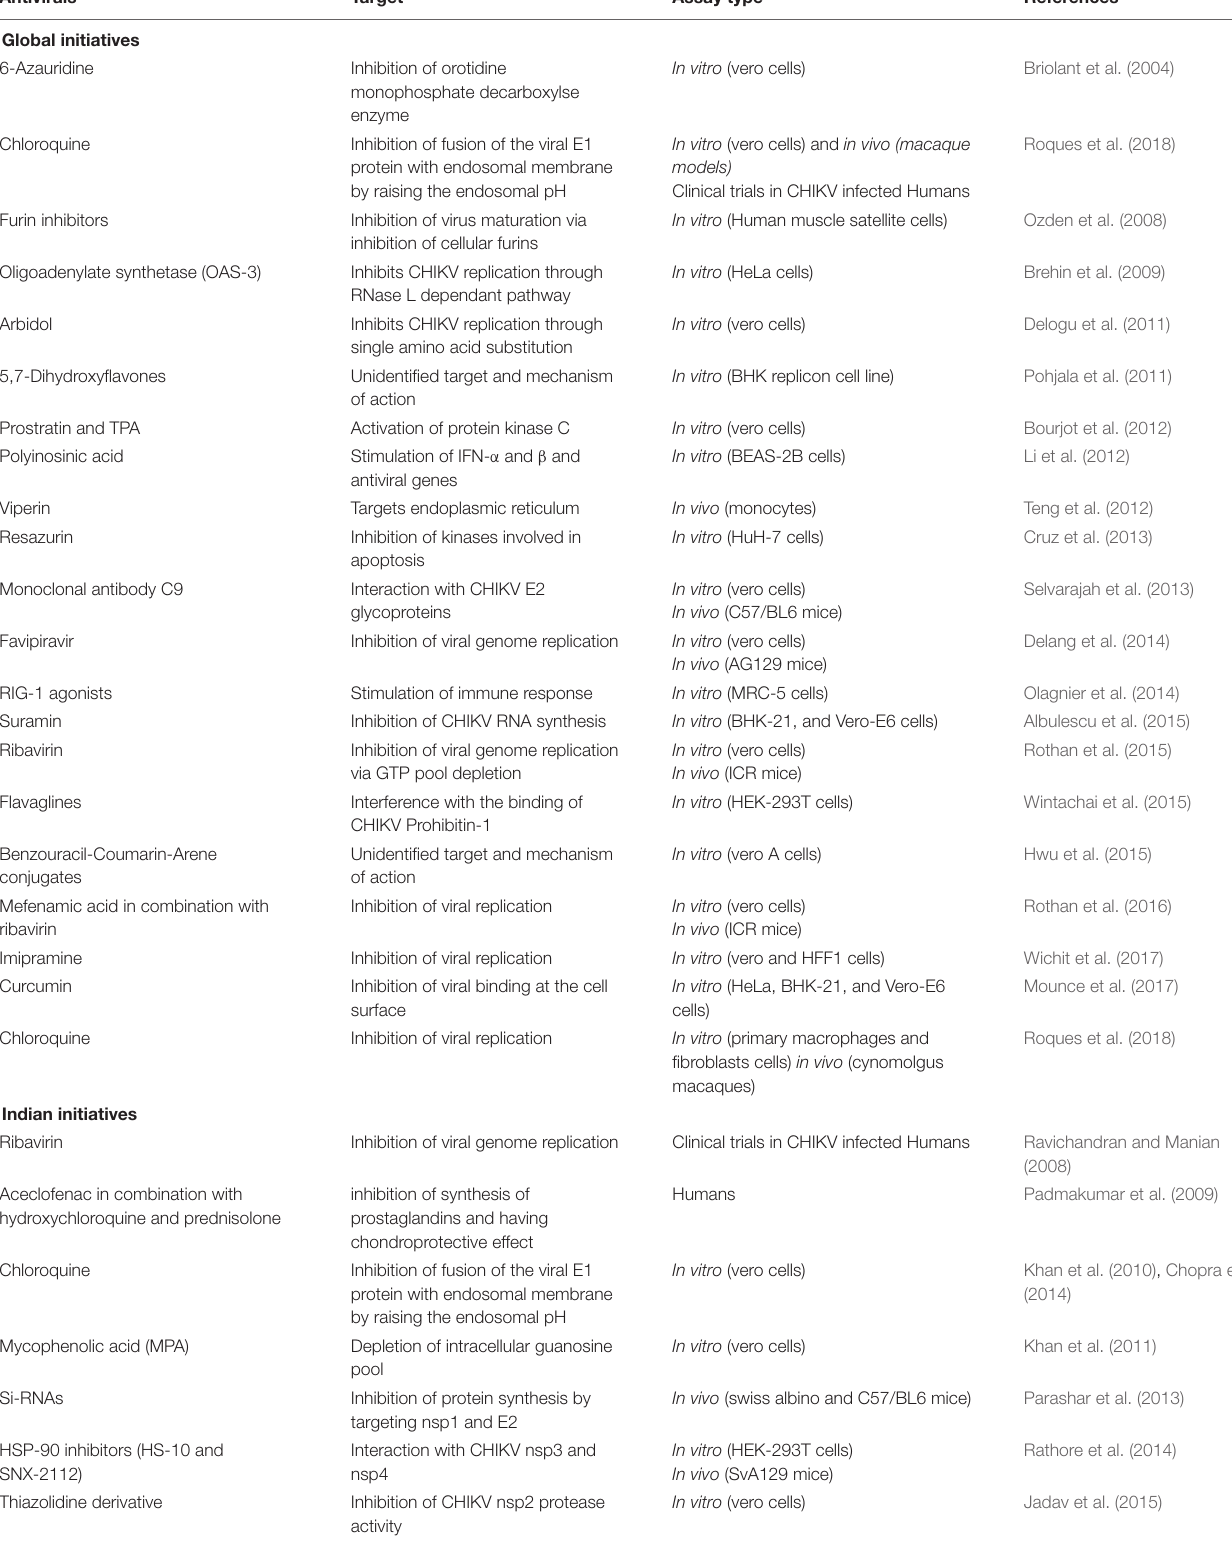
TABLE 4 | Showing tested antiviral drugs against